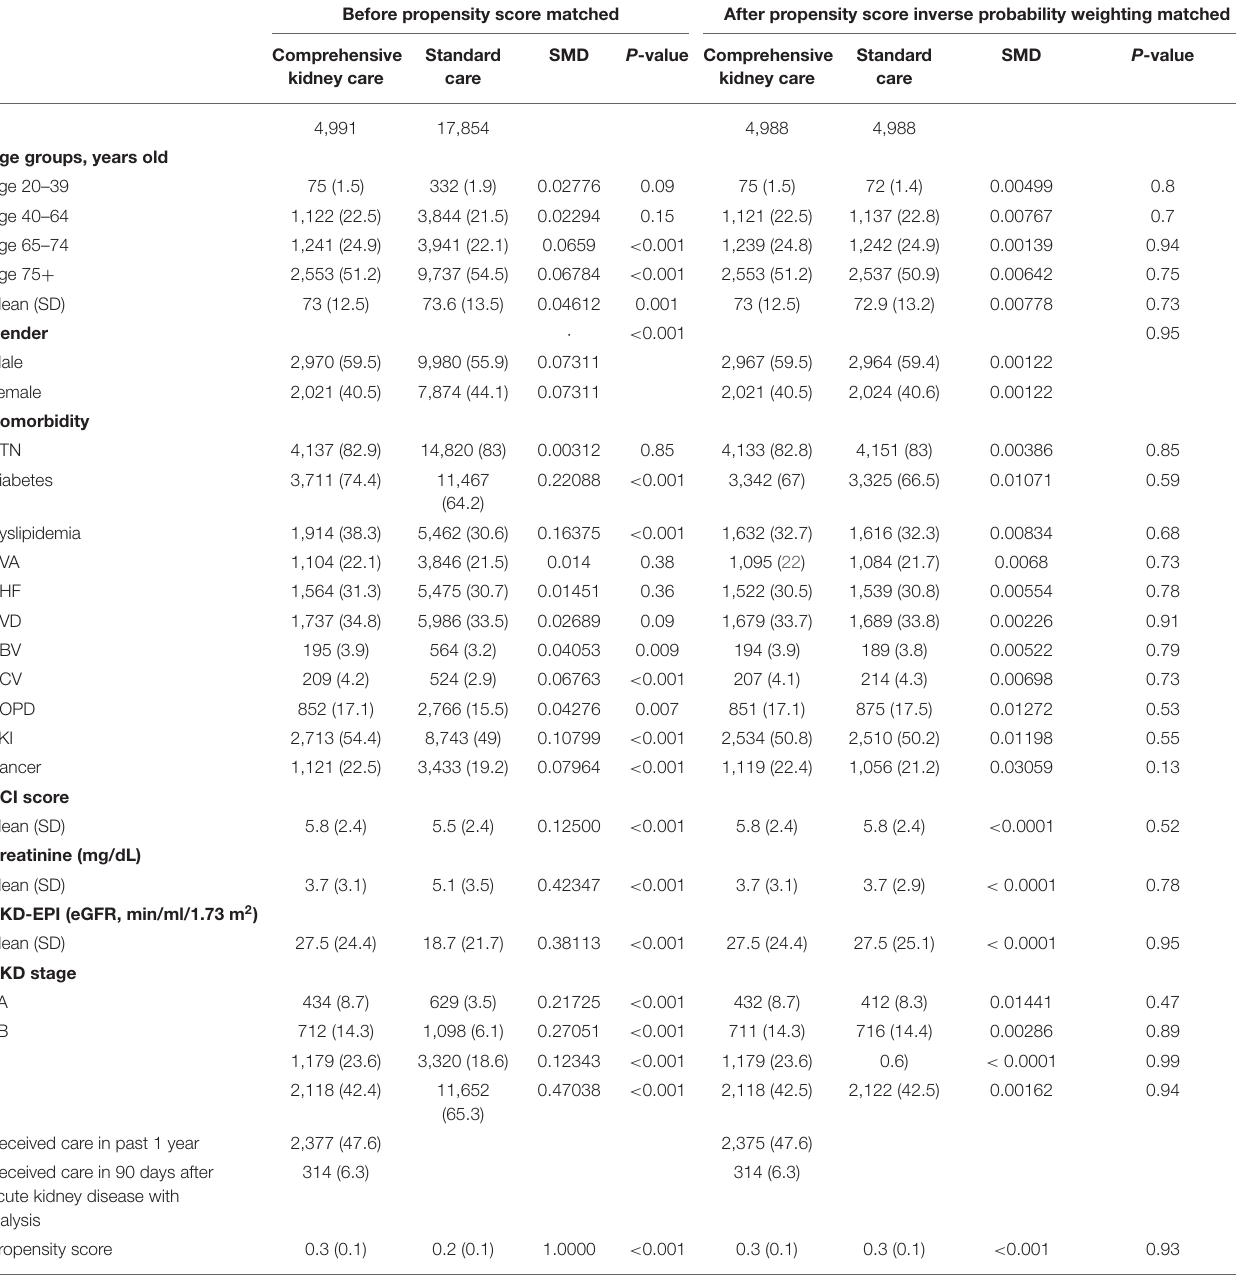
TABLE 1 | Demographic characteristics of dialysis-requiring acute kidney injury survivors receiving comprehensive kidney care or standard care. Before propensity score matched After propensity score inverse probability weighting matched Comprehensive Standard SMD Standard kidney care care